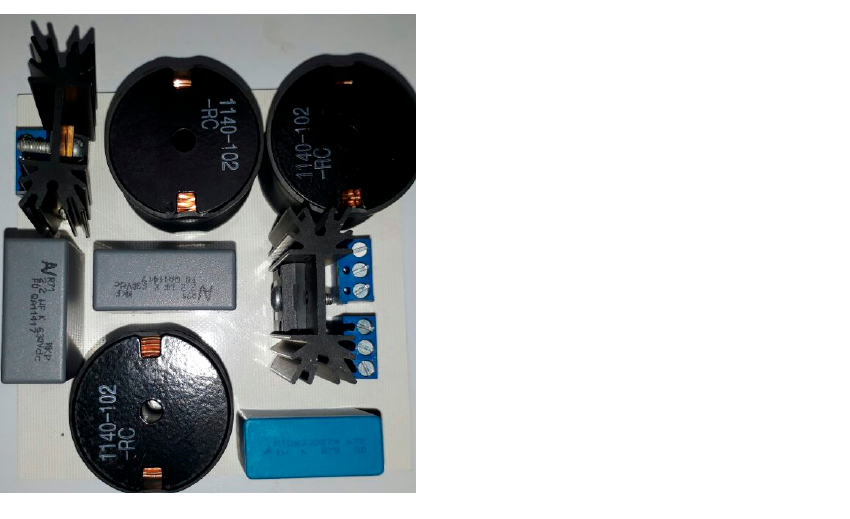
10 of 16 Table 2. Z-source converter design parameters. Figure Parameter